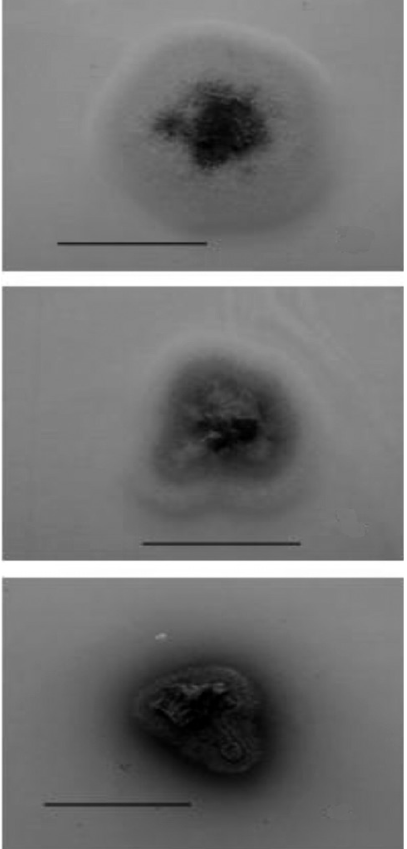
Figure 1. Colony morphology of Phaeoacremonium aleo- philum groups (a,b,c) grown on malt extract agar at 37ºC for 14 days (scale bar=10